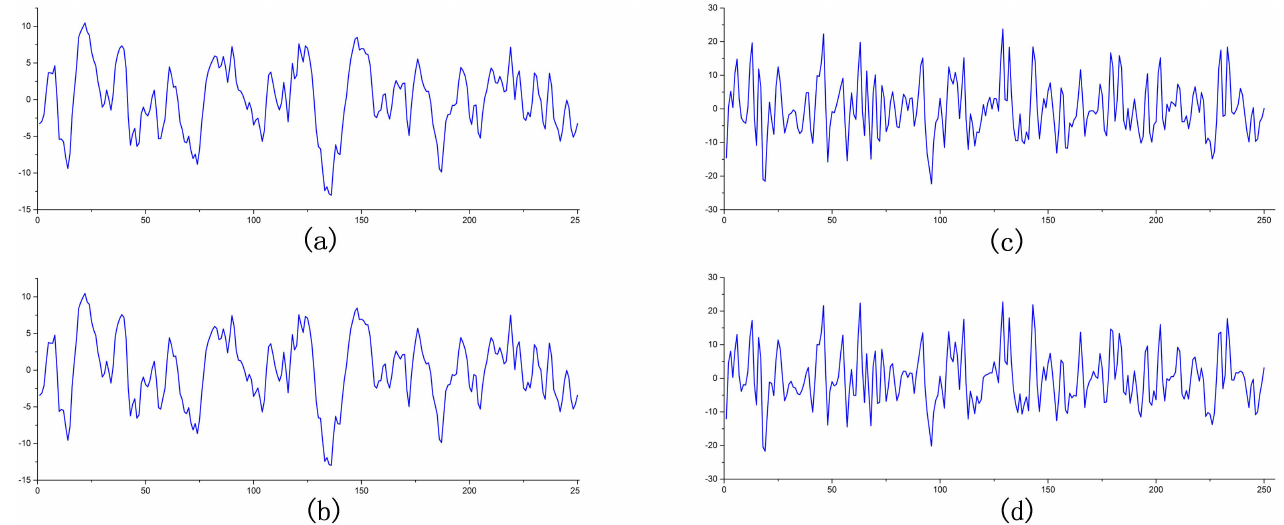
Figure 7. Comparison before and after signal compression: ( a ) EEG original signal of target 44. ( b ) Compressed reconstructed signal of target 44 (bits = 6, CR = 7.95, PRD = 2.84). ( c ) EEG original signal of target 16. ( d ) Compressed reconstructed signal of target 16 (bits = 3, CR = 12.7, PRD =